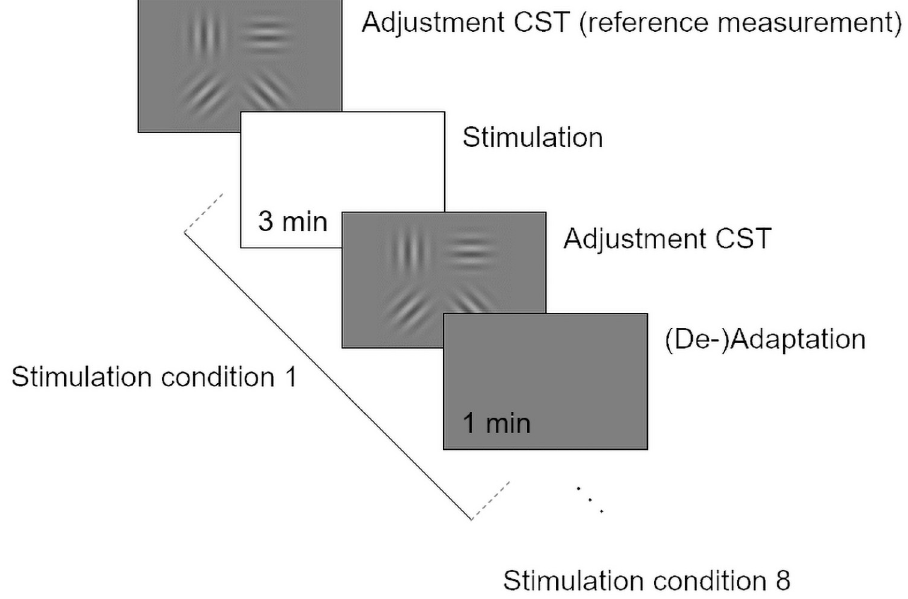
Fig 3. Main study test procedure with a total of 8 repetitions due to 8 stimulation